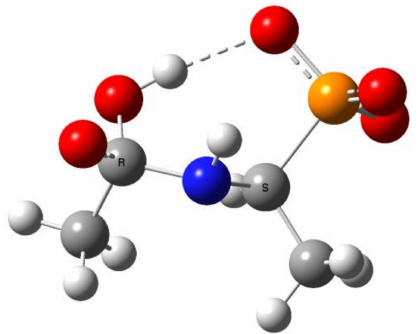
Figure 10. The structure of the addition product 2 (R=R 1 =Me, Ac(OH)-Ala P ) with intramolecular hydrogen bond between OH and phosphoryl group (orange—phosphorus, blue—nitrogen,